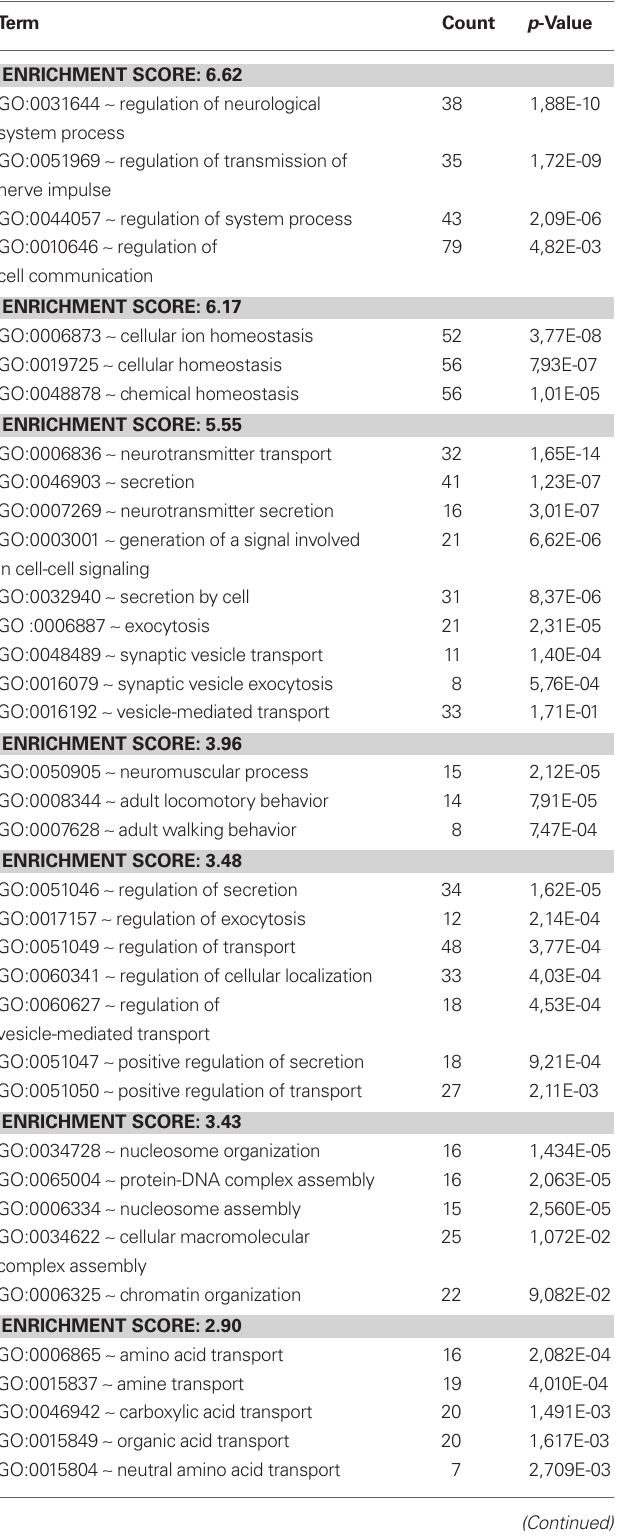
Table 3 | Avulsion vs replantation. A cluster analysis of the response to avulsion compared to the response to replantation after avulsion. Themes relating to synaptic transmission are